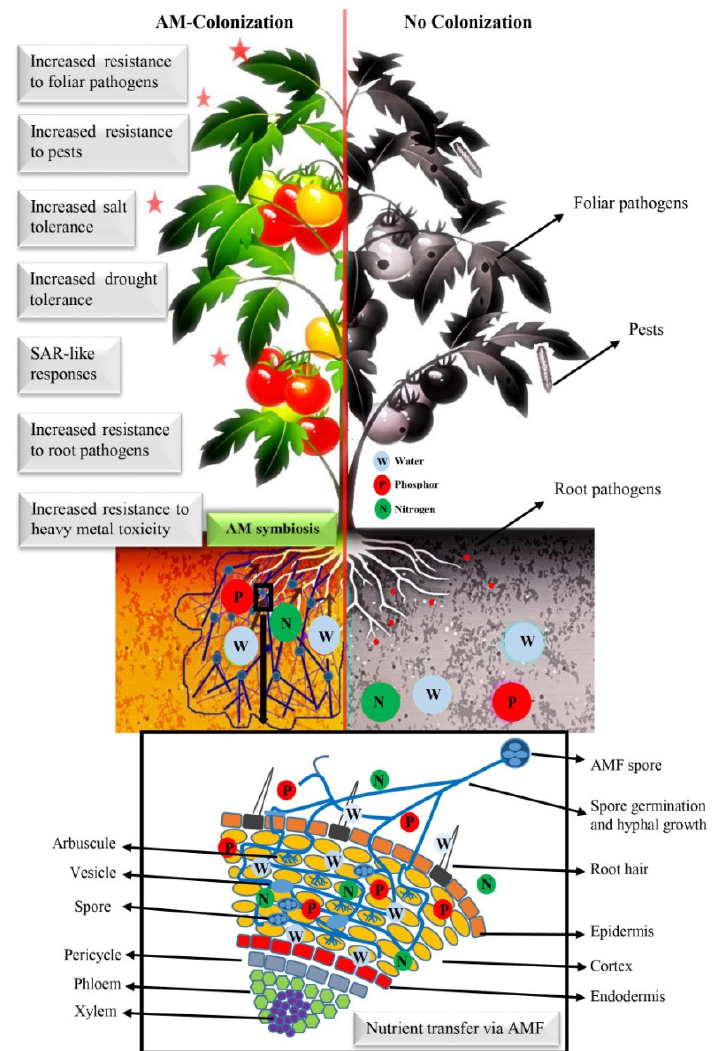
Figure 1. Schematic representation of the interaction between arbuscular mycorrhizal fungi (AMF) with the host plant and their functions (Figure by Boyno, G.).